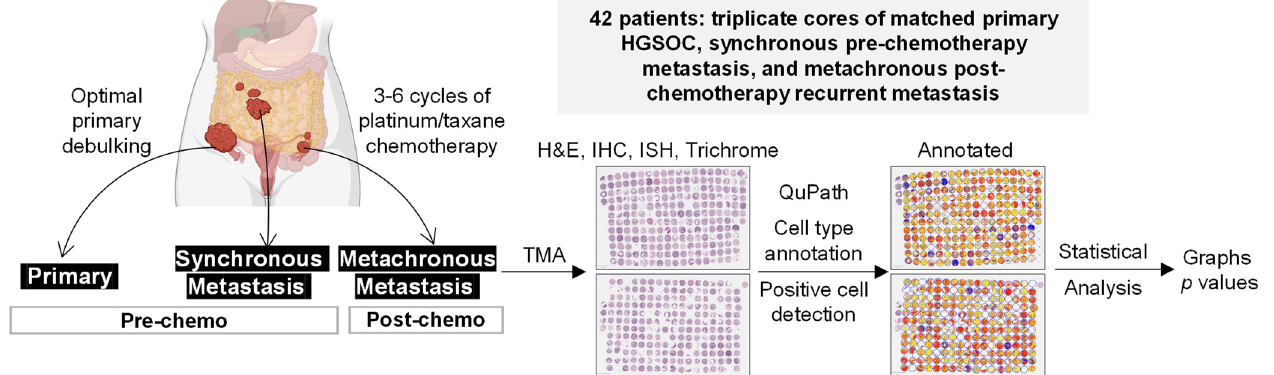
Figure 1. Workflow diagram of TMA generation, cell type annotation/positive cell detection, and statistical analysis. HGSOC, high-grade serous ovarian cancer; TMA, tissue microarray; H&E, he- matoxylin, and eosin; IHC, immunohistochemistry; ISH, in situ